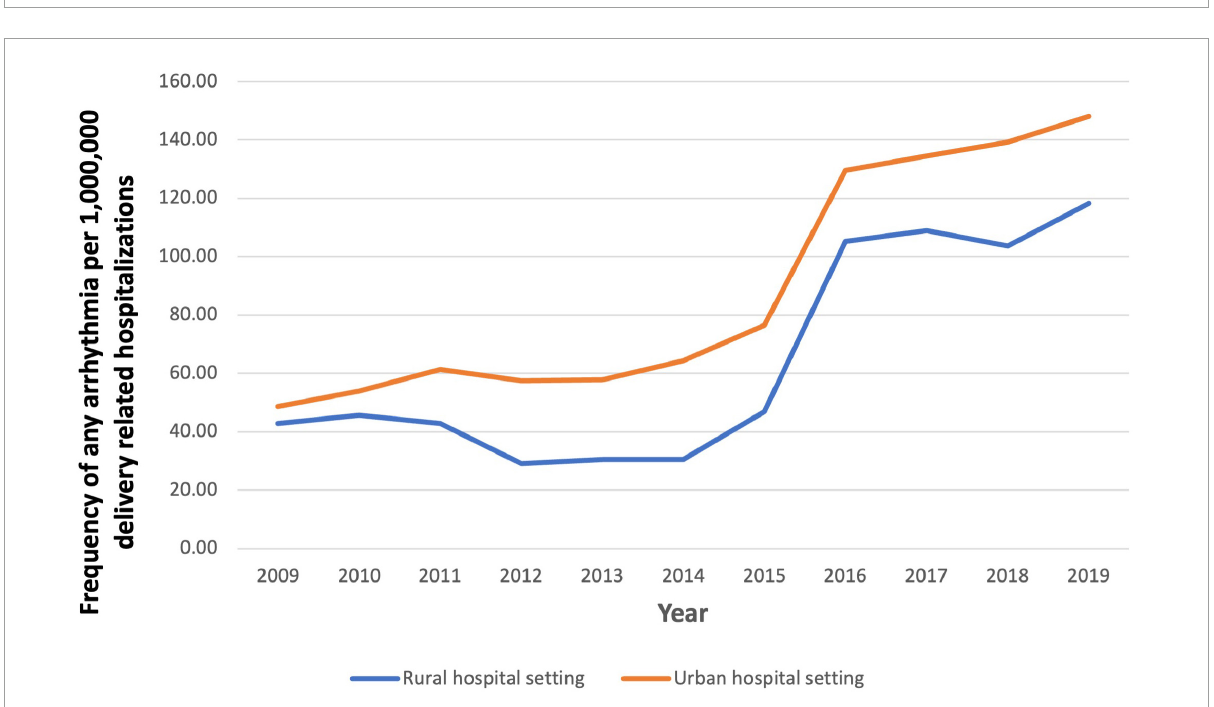
FIGURE6 Frequency of any arrhythmia per 1,000,000 delivery related hospitalizations from 2009 to 2019, stratified by hospital setting.